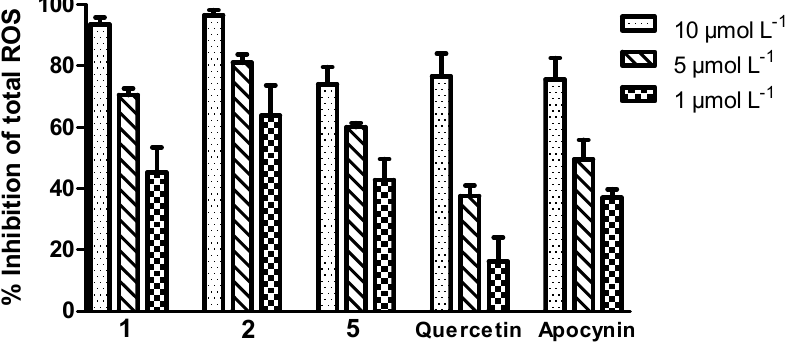
Figure 3. The ability of the tested compounds and standards to inhibit the total ROS produced by stimulated